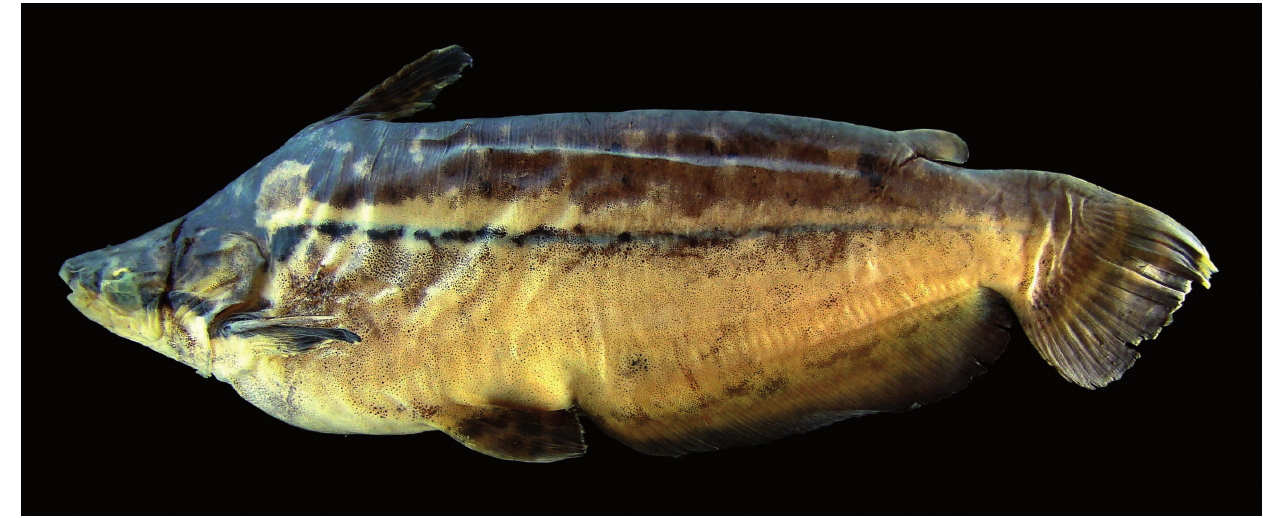
Fig. 2. Tetranematichthys barthemi , paratype, female, MPEG 14565, 175.7 mm SL. Lateral view.